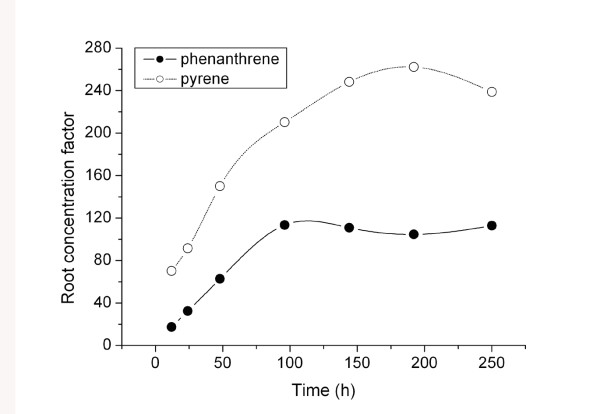
Root concentration factor (RCF) of phenanthrene and pyrene for ryegrass uptake from aqueous solution. Root concentration factor (RCF) describes the capability of roots to accumulate contaminants from the direct contact with the aqueous environment, which is here defined as the ratio of PAH concentration in root (Croot) to that in culture medium (Csolution), i.e., RCF = Croot/Csolution.